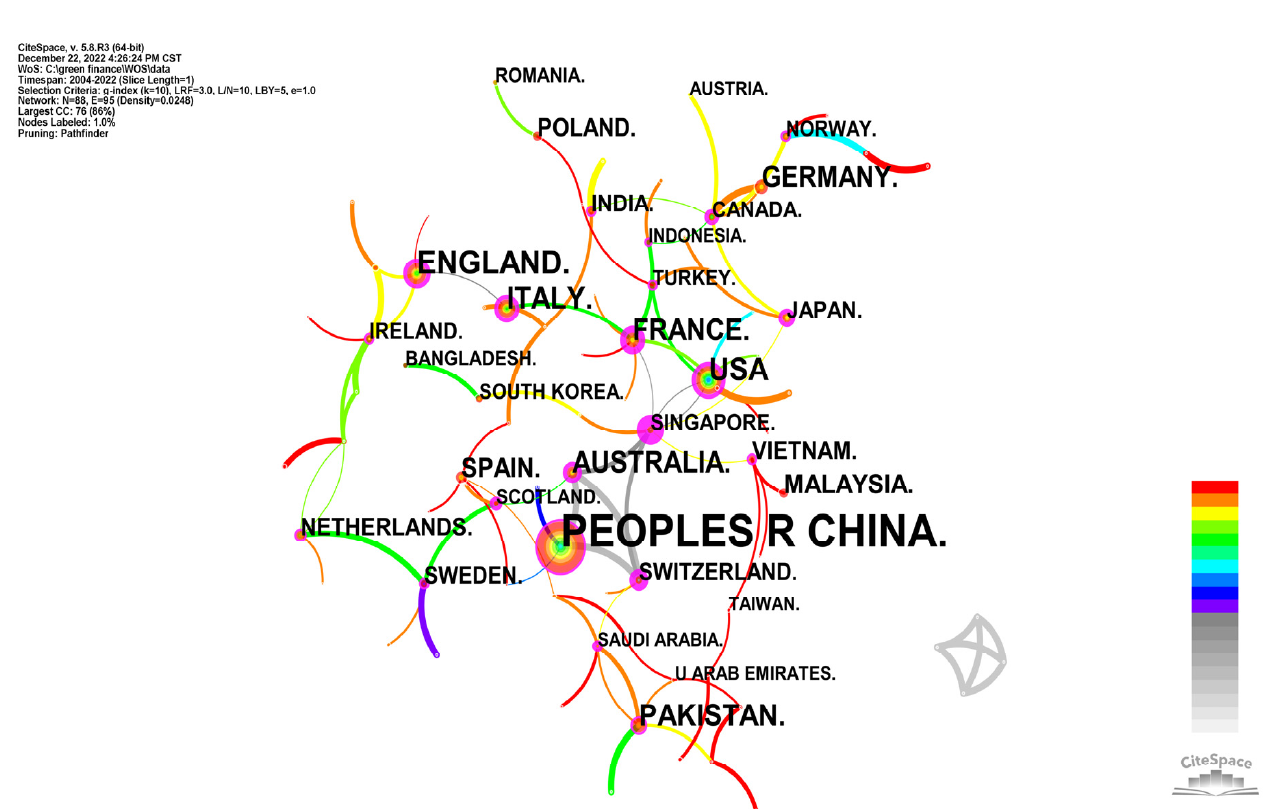
Figure 7. Map of the national cooperation networks.